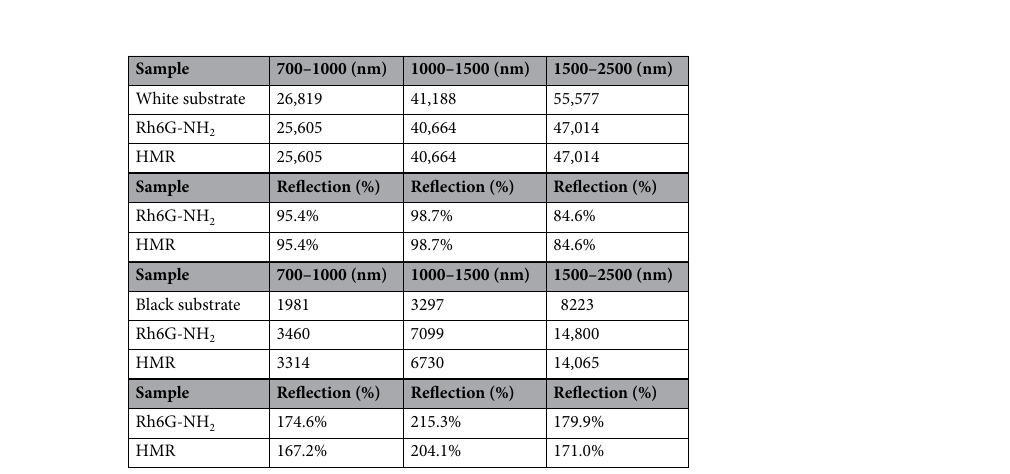
Figure 9. UV–Vis-NIR spectra of Rh6G-NH 2 and HMR.